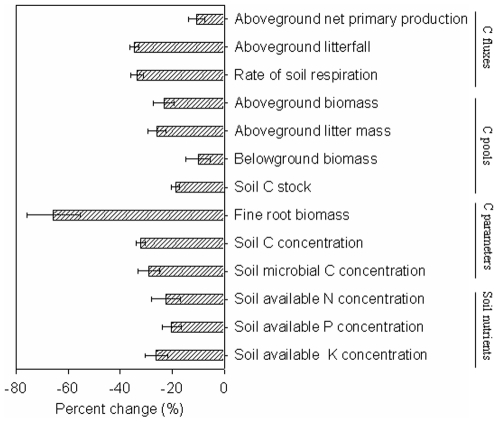
Percent changes of variables related to ecosystem C fluxes and pools, and soil nutrients in plantations relative to natural forests.Bars represented mean±95% confidence interval (CI).